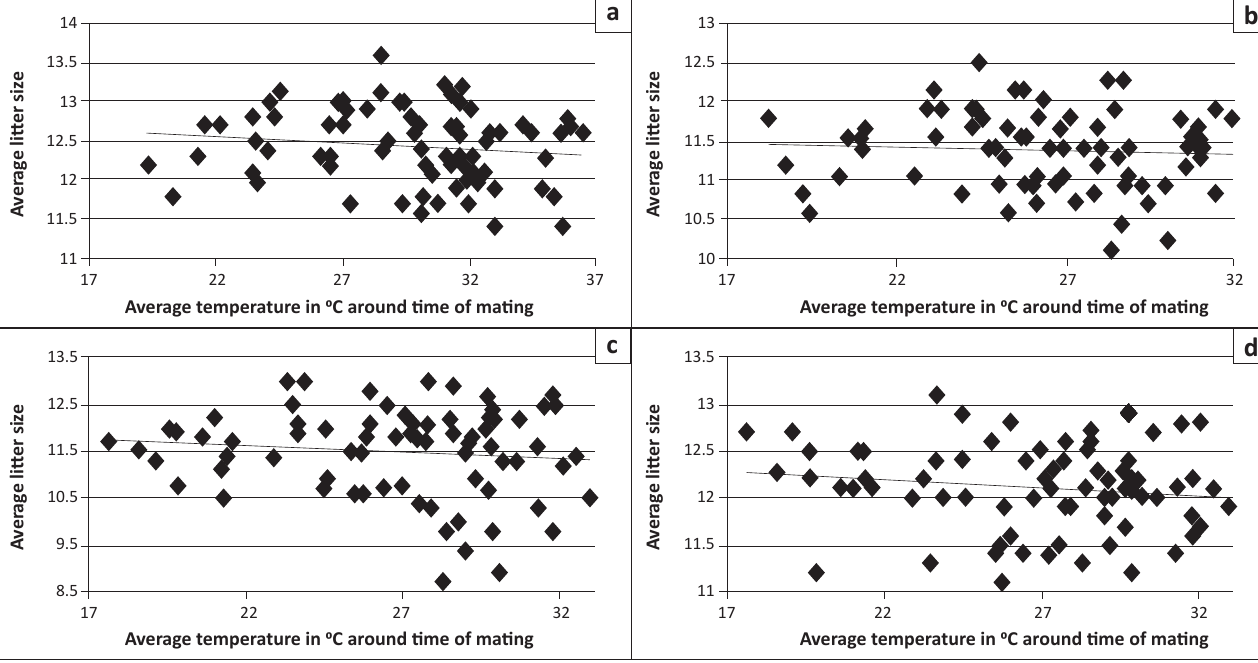
FIGURE 2: The effect of various temperatures around the time of mating on litter size. (a) Breeding unit 1, (b) breeding unit 2, (c) breeding unit 3 and (d) breeding unit 4. in unit 2 (Table 1). Trend lines indicated that the farrowing rate decreased with increase in environmental temperature (Figure 1), with the steepest decrease in unit 2 (Figure 1b) and the least evident decrease in unit 4 (Figure